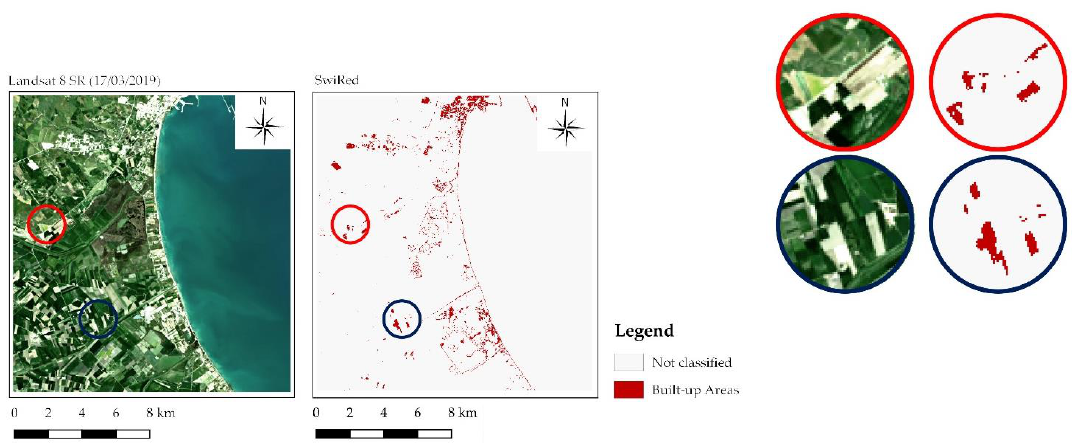
Figure 10. SwiRed index (SwiRed) classification outcome for Landsat 8 (image acquired on 17 March 2019). On the right, zoomed images with some misclassifications.